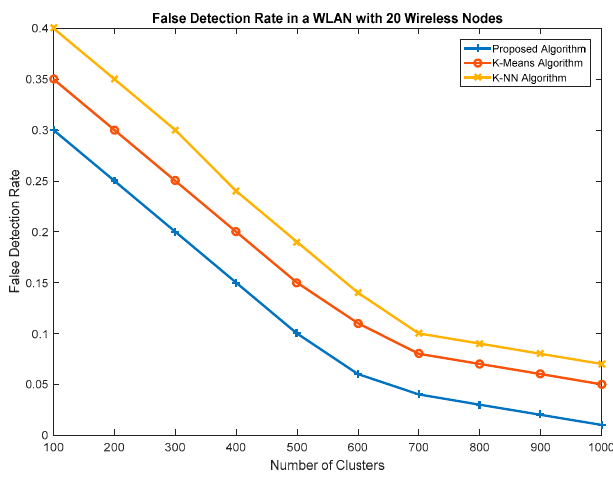
Figure 8. False Detection Rate (FDR) versus of the number of clusters.